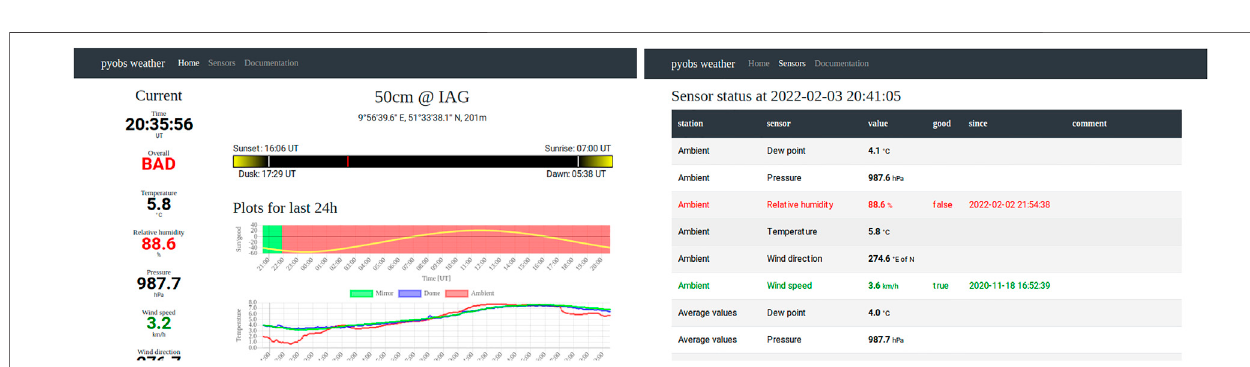
FIGURE 6 | Screenshot of the pyobs-archive instance that we use for the MONET telescopes and the IAG50 cm telescope.